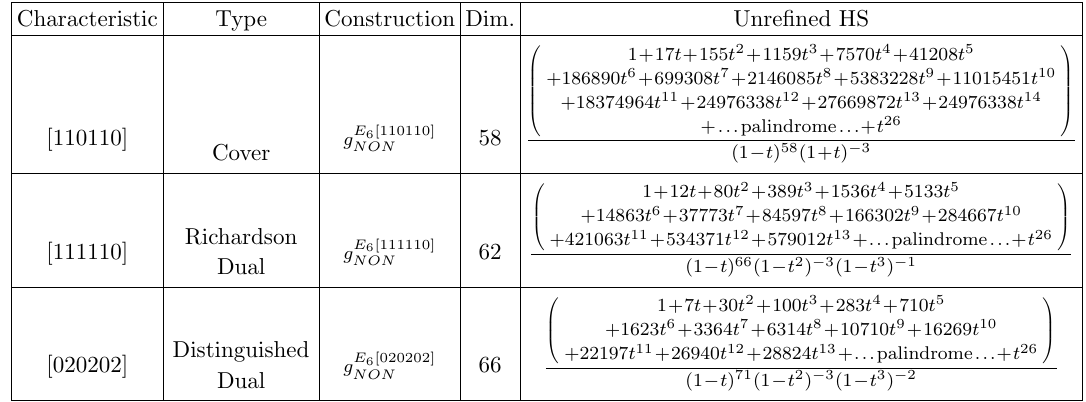
Table 16 . E 6 extra moduli spaces and Hilbert series. These moduli spaces are associated with SU(2) homomorphisms but do not represent additional nilpotent orbits (see text).